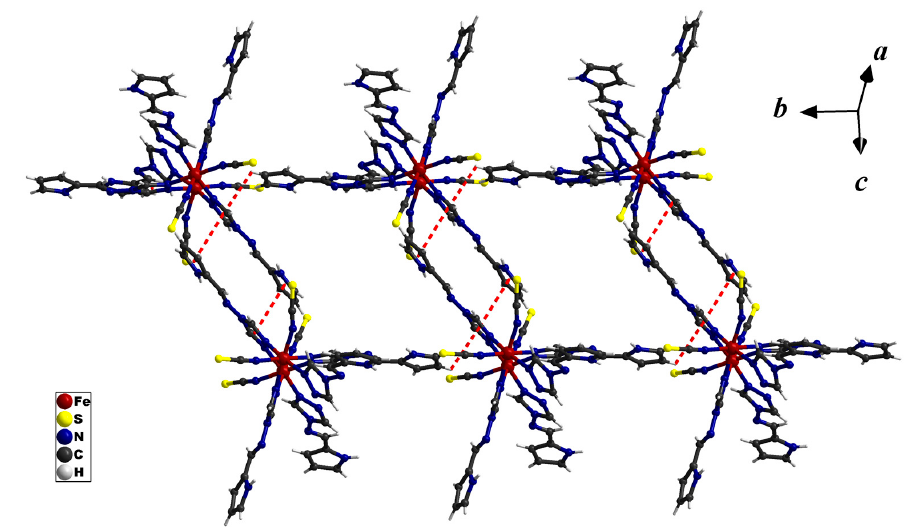
Figure 4. The π ⋅⋅⋅ π stacking in bc plane of compound 1 . Figure 4. The π · · · π stacking in bc plane of compound 1